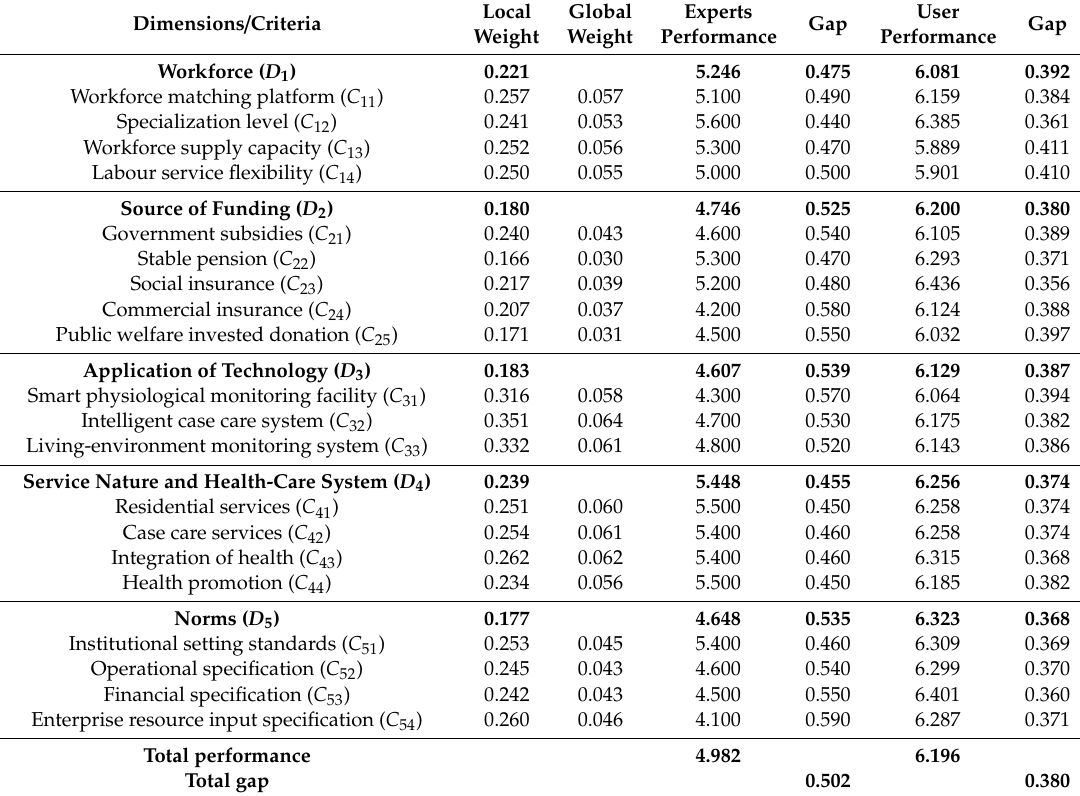
Table 2. Evaluation results of Taiwan’s long-term ageing health care